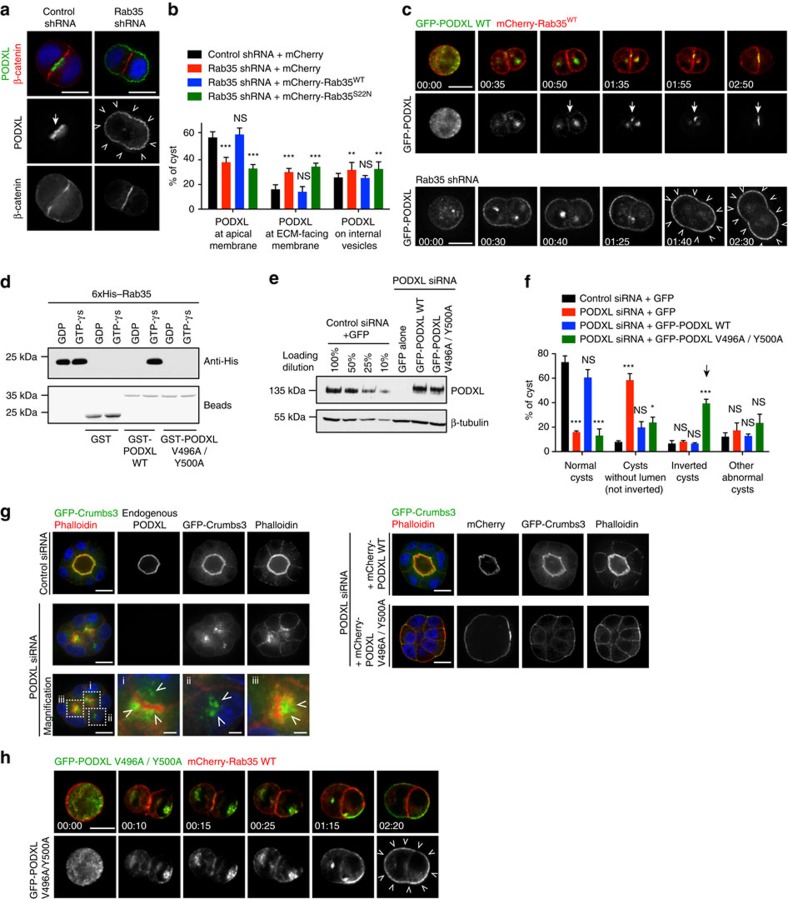
Ectopic fusion of PODXL-positive vesicles to the ECM-facing membrane on Rab35 depletion or disruption of Rab35/PODXL interaction.(a) Staining for PODXL, β-catenin and DAPI in control- or Rab35-depleted two-cell cysts fixed 24 h after seeding in Matrigel (merge and single channels, as indicated). Scale bar, 10 μm. (b) Localization of PODXL at the two-cell-stage cyst (24 h in Matrigel) after indicated depletion and plasmid transfection. Mean±s.d., N=3 independent experiments, 150–200 two-cell cysts analysed per condition. Two-way analysis of variance (ANOVA): **P<0.01, ***P<0.001, NS, not significant. (c) Top two rows: snapshots of time-lapse microscopy from control MDCK cells seeded into Matrigel and expressing mCherry-Rab35WT (red) together with GFP-PODXL (green). Bottom row: snapshots of time-lapse microscopy from Rab35 shRNA MDCK cells seeded into Matrigel and expressing GFP-PODXL. Arrowheads indicate ectopic localization of PODXL after the first division. Scale bar, 10 μm. Time stamps: (hour:min) using mitotic entry as origin. (d) GST-pull down experiment as described in Fig. 1b, using either GST alone, GST–PODXL tail (aa 476–551) as in WT or GST–PODXL tail (aa 476–551) with the two substitutions V496A and Y500A. (e) MDCK cells treated with PODXL siRNAs for 3 days and transfected with indicated plasmids. Western blot showing PODXL (loading control: β-tubulin). For comparison, dilutions of lysates from control siRNA-treated MDCK cells transfected with plasmids encoding GFP alone have been used. 100% correspond to the amount loaded in the PODXL siRNA conditions. (f) Proportion of normal cysts, cysts without lumen (but not inverted), inverted cysts and other abnormal cysts following seeding of the cells described in e. in Matrigel for 48 h. Mean±s.d., N=3 independent experiments, 150–500 cysts analysed per condition. Two-way ANOVA: *P<0.05; ***P<0.001; NS, not significant. (g) MDCK cells as described in e were co-transfected with GFP-Crumbs3, fixed after 48 h in Matrigel and stained as indicated. Magnification: GFP-Crumbs3-positive vesicles close to the plasma membrane in displayed PODXL-depleted cyst. Scale bar, 10 μm (2 μm for zoomed region). (h) Snapshots of time-lapse microscopy from PODXL-depleted MDCK cells seeded into Matrigel and expressing mCherry-Rab35WT (red) together with siRNA-resistant GFP-PODXL full-length V496A Y500A mutant (green). Single PODXL channel also displayed in grey levels. Arrowheads indicate ectopic localization of PODXL mutant after the first division. Scale bar, 10 μm.